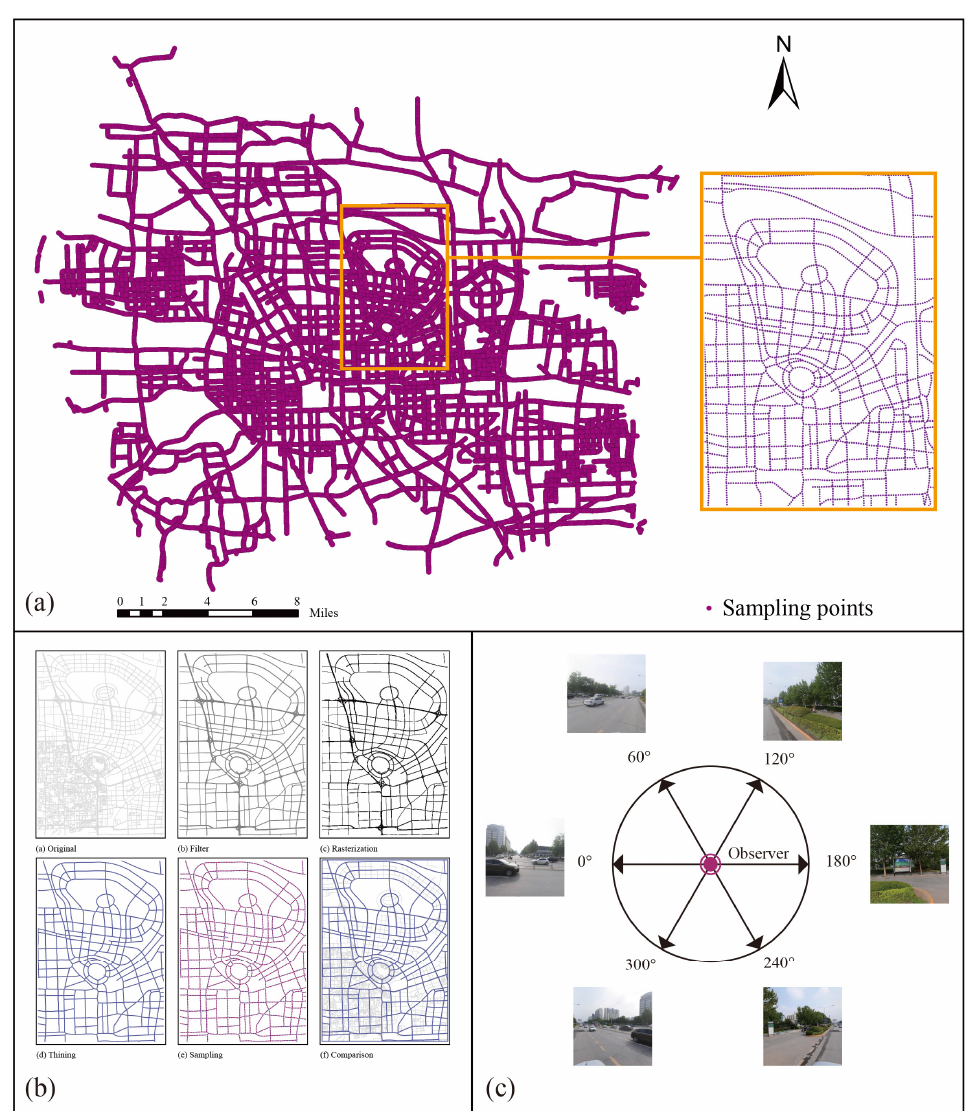
Figure 3. ( a ) Sampling point location and number distribution; ( b ) road network simplification pro- cedures; ( c ) the configuration of Baidu map street view (BSV)